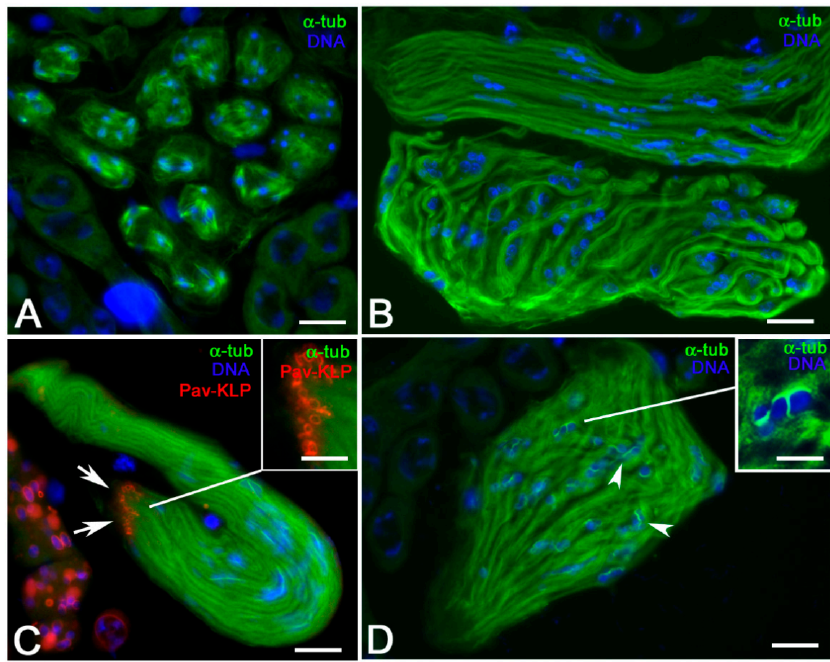
Figure 8. Spermatogenesis and spermiogenesis in Sas-4 mutant testis. ( A ) Abnormal meiosis with the formation of multiple spindles in primary spermatocytes. ( B ) Despite the absence of basal bodies, the cytoplasm of the elongating spermatids is filled with many MTs. ( C ) Nuclei are scattered within the spermatid cytoplasm, but the ring canals, stained with an antibody against Pavarotti (Pav-KLP), are normally clustered at the end of the spermatid tails (arrows and inset). ( D ) MT bundles are often observed close to the nuclei (arrowheads and inset). Scale bars: ( A – D ) 10 µ m; insets, 3 µ